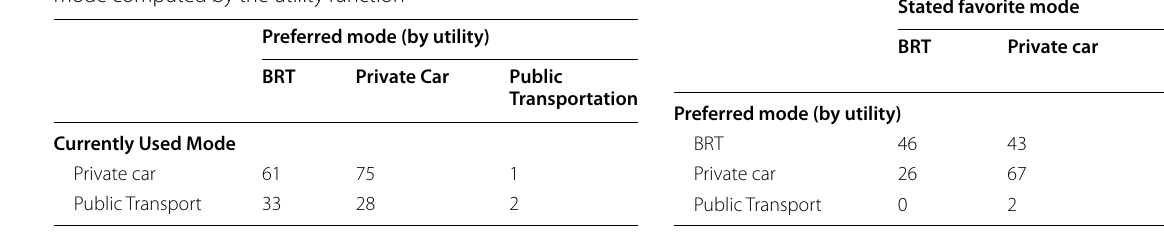
Table 6 Cross‑classification of preferred mode computed with the utility function, and stated preferred mode Stated favorite